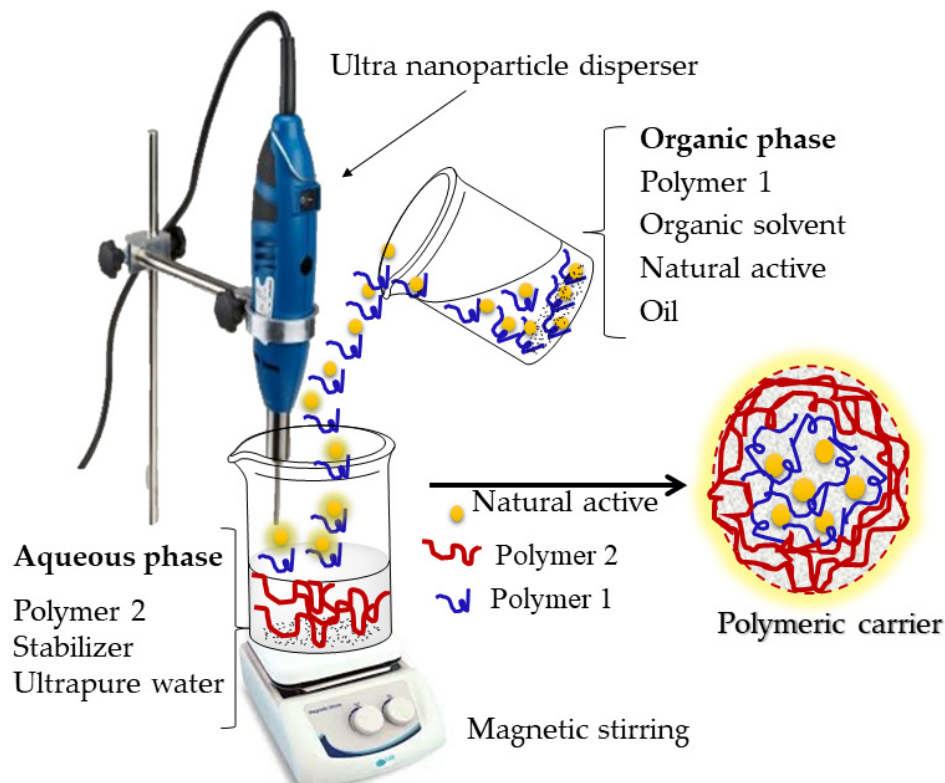
Figure 4. Formation of carrier systems using the emulsion–diffusion method. The organic phase contains the polymer, the organic solvent, the natural active ingredient, and the oil. The aqueous phase contains a different polymer, a stabilizer and the ultrapure water. The particles are formed by polymer precipitation along with the encapsulation of the natural active ingredient.